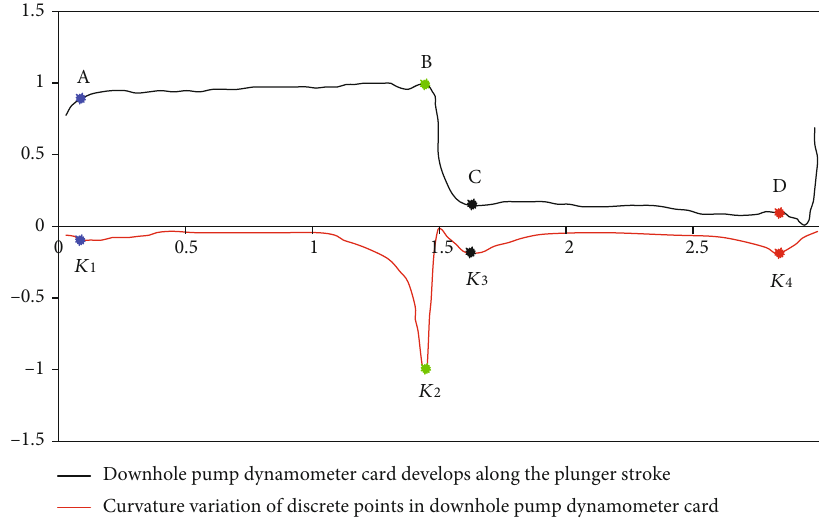
Figure 2: Determination of opening and closing points of pump